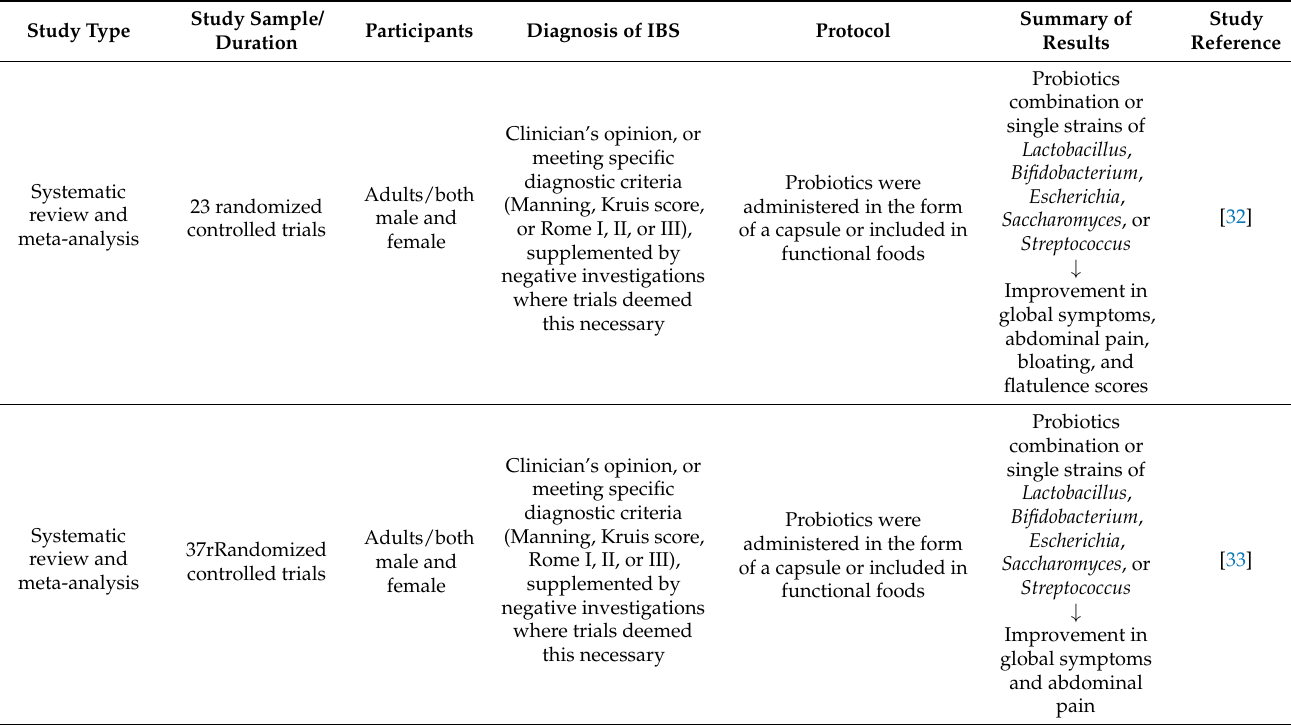
Table 1. Studies that summarize the efficacy of probiotics in treating irritable bowel